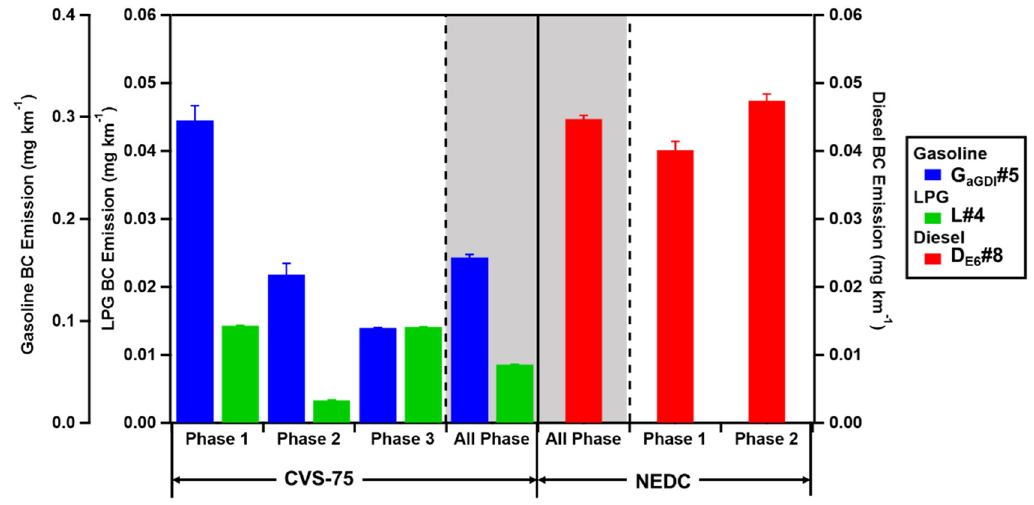
Figure 5. BC emission from different fuel types by regulation mode. CVS-75 for gasoline vehicle with GDI engine after PM regulation and LPG vehicle. NEDC for diesel vehicle of EURO 6.